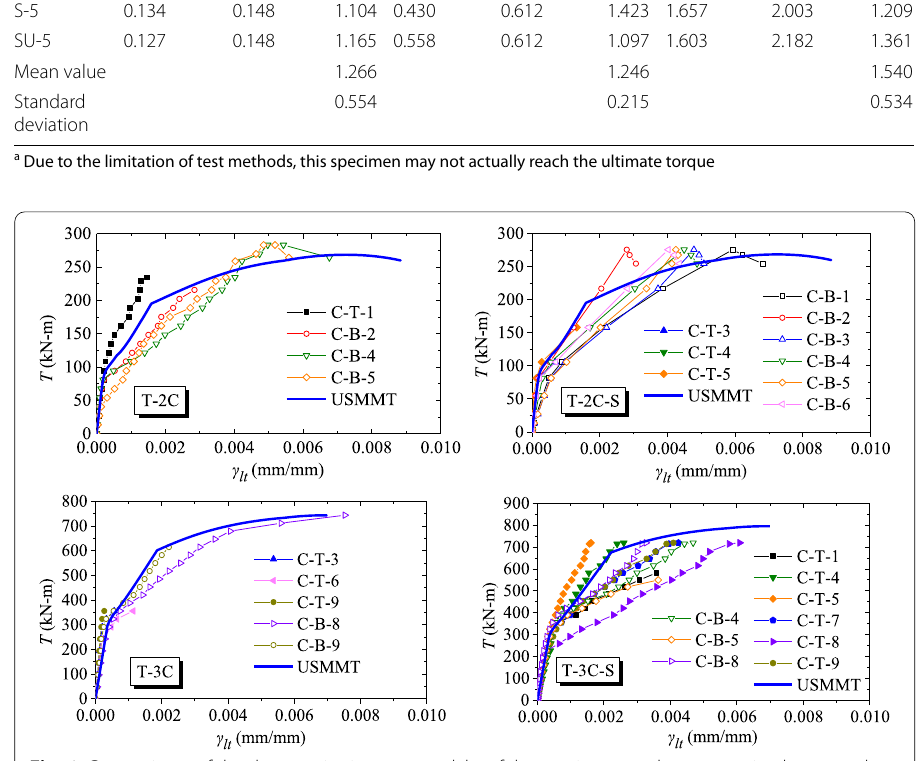
Fig. 6 Comparisons of the shear strains in concrete slabs of the specimens under pure torsion between the experimental results and the calculated results from the